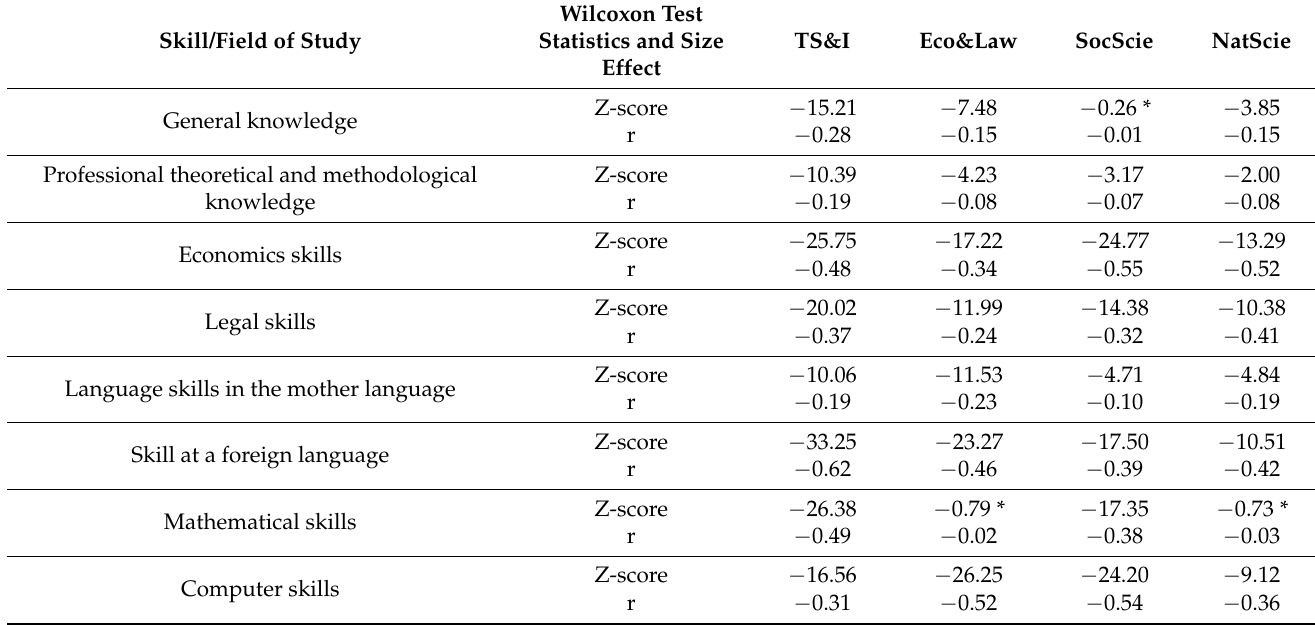
Table 3. Differences between acquired and required skills in particular fields of